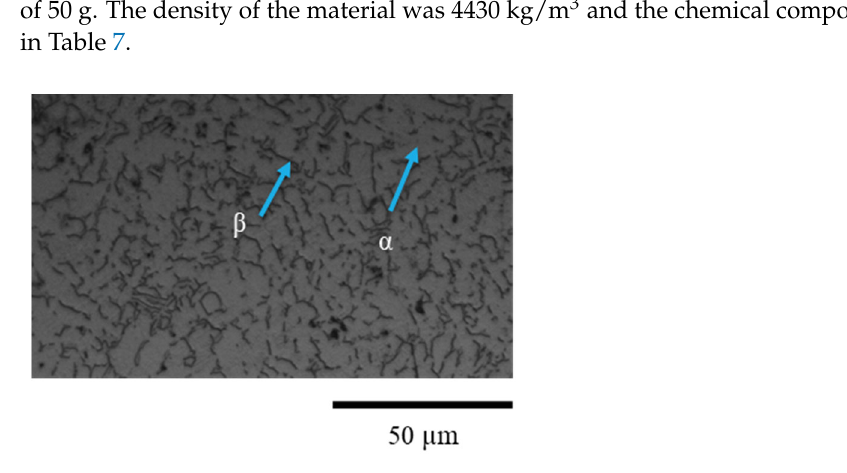
Figure 3. Initial microstructure of the Ti6Al4V employed. Figure 3 . Initial microstructure of the Ti6Al4V employed. Figure 3 . Initial microstructure of the Ti6Al4V employed. Table 7. Chemical composition of the Ti6Al4V alloy. Table 7. Chemical composition of the Ti6Al4V alloy. Table 7. Chemical composition of the Ti6Al4V alloy.